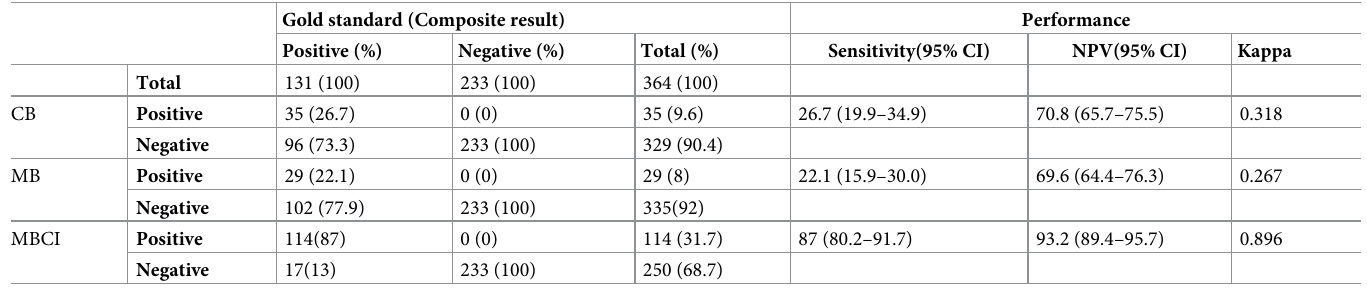
Table 2. Diagnostic performance of the three Baermann techniques against the composite reference